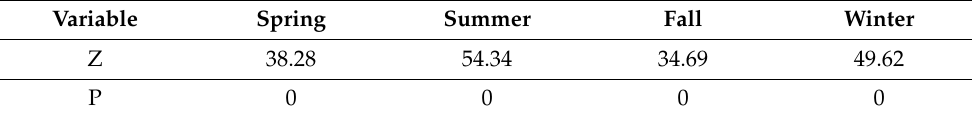
Table 8. Global Moran’s I analysis on the risk level of heavy rain and flood in Chongqing. Variable Spring